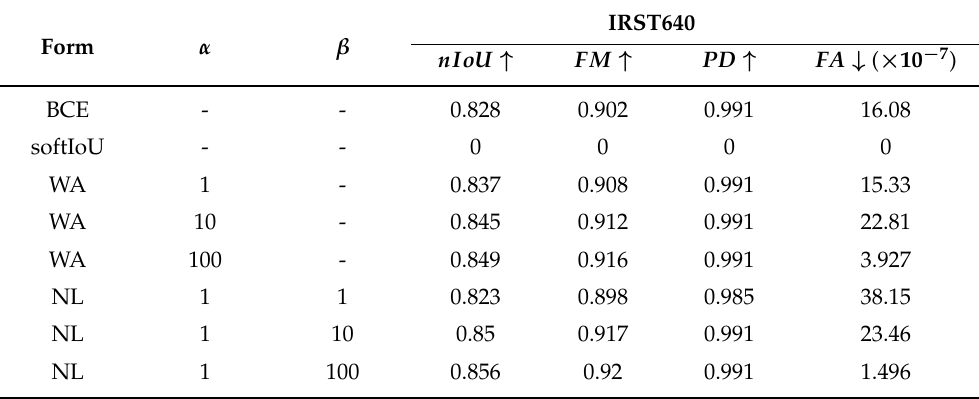
Table 7. Results of different forms of loss function combination on the IRST640